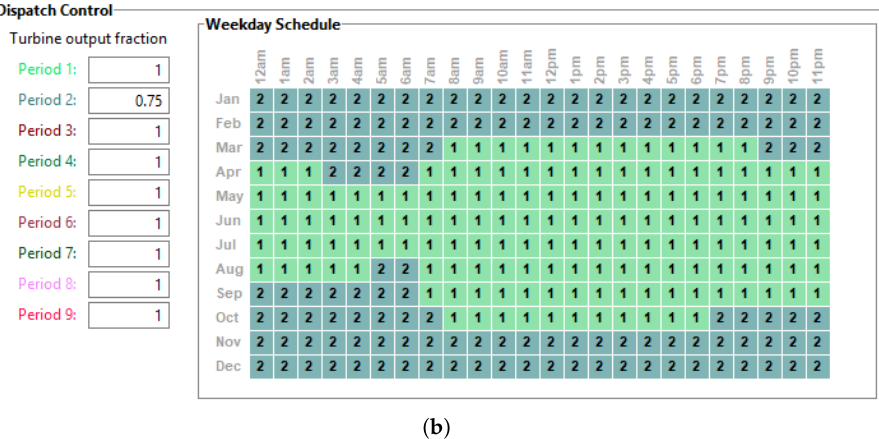
Figure 5. Different dispatch controls used to assess the Levelised Cost of Electricity. ( a ) System advisor model’s (SAM’s) default dispatch control. ( b ) Dispatch control scheme for the SunShot Vision case [28].